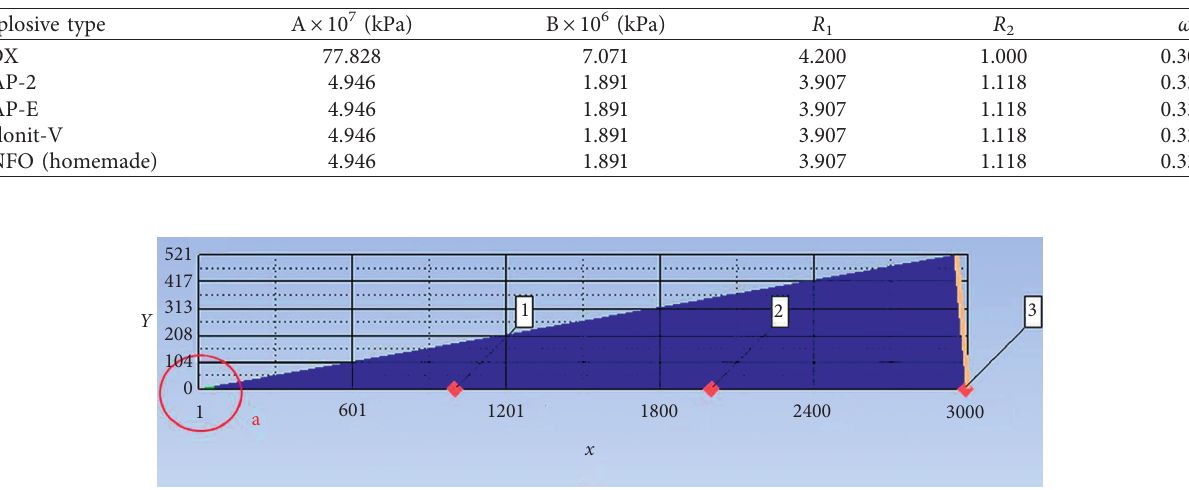
Figure 5: 1D wedge element made of the explosive and air zone based on the Euler multimaterial solver (homemade ANFO charge in the example). In evidence, the blast wave pressure at a given distance from detonation point “a.” Distance values are given in mm ( x -axis), while the pressure values are in kPa.